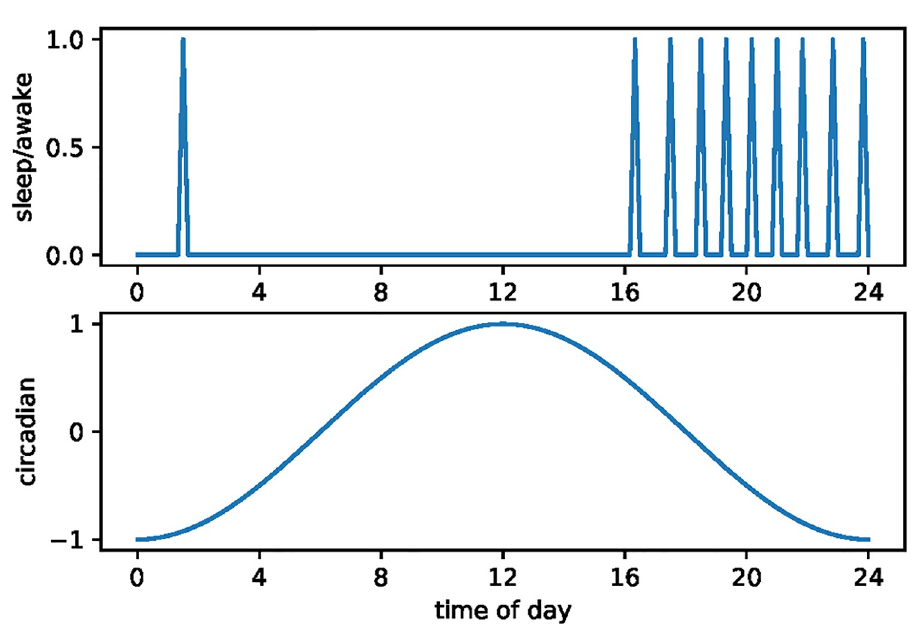
Fig 7. Stylized elephant sleep patterns with low switching